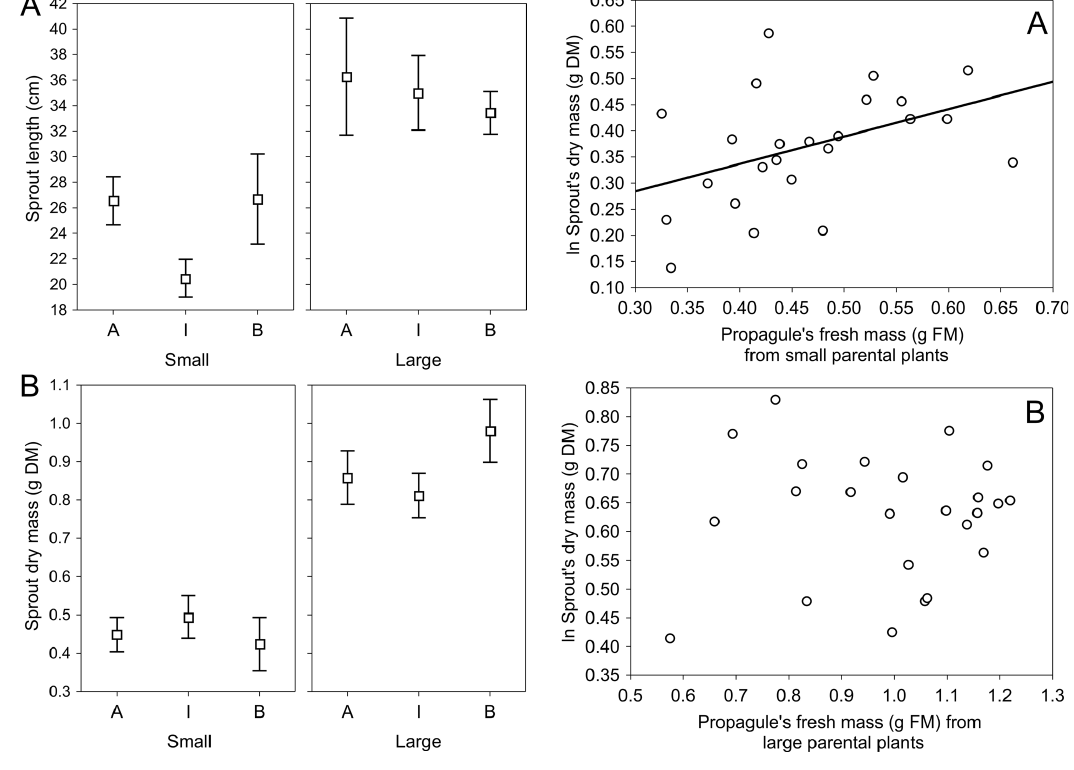
Figure 2. Mean (± SE – Standard Error) of length (A) and dry mass (B) of U. arrecta ’s new sprouts at the end of experiment (37 days) in different parental size (large and small plants) and position from which the fragment originates (apical-A, intermediate-I and basal-B) (N = 8 for each